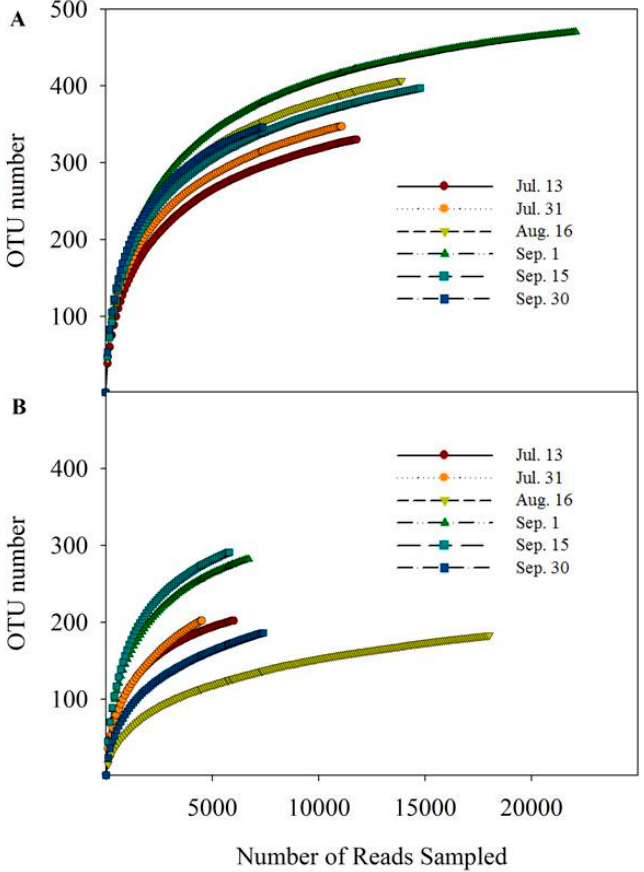
Figure 2. Waterbacterial ( A ) and fungal ( B ) communities operational taxonomic units (OTUs) number at 0.97 level and the reads number sampled in Zhoucun drinking water reservoir during algal bloom outbreak and decline from July to September, 2012.